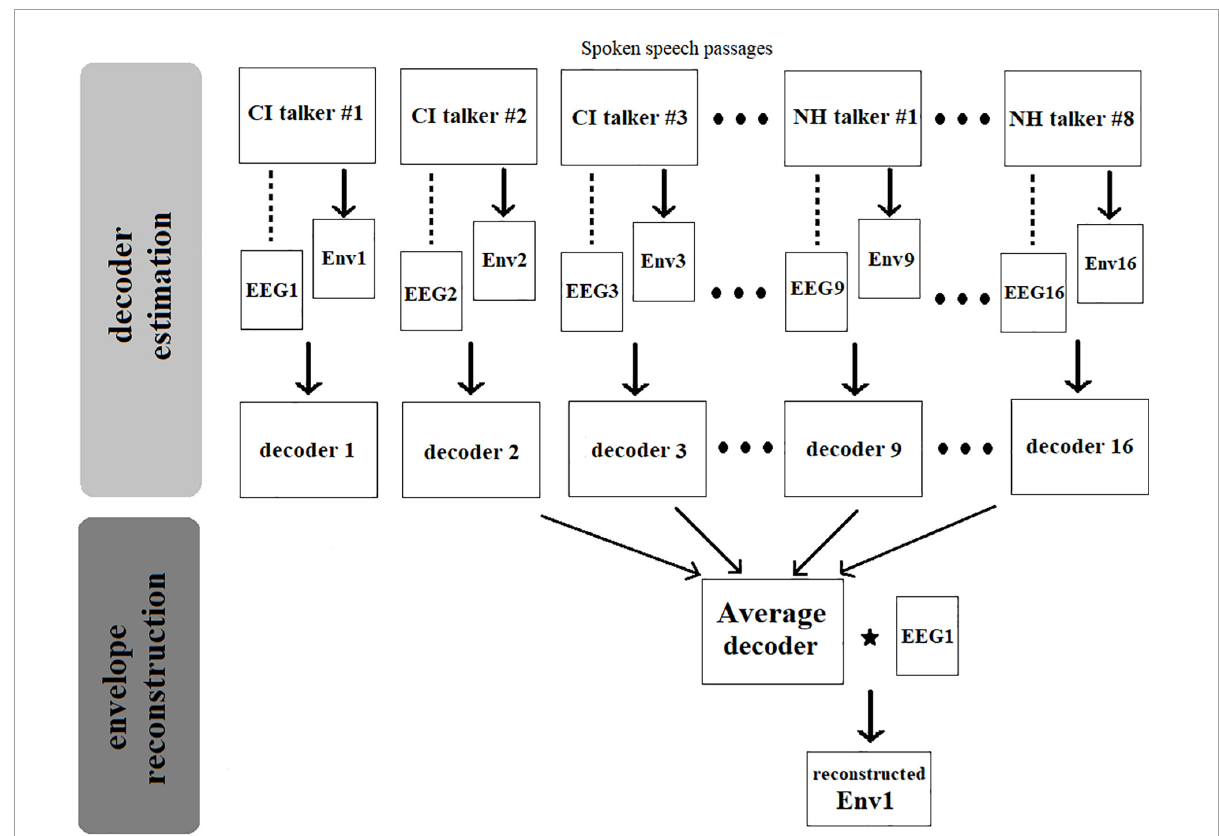
FIGURE3 Flowchart illustrating the stages involved in the reconstruction of a speech